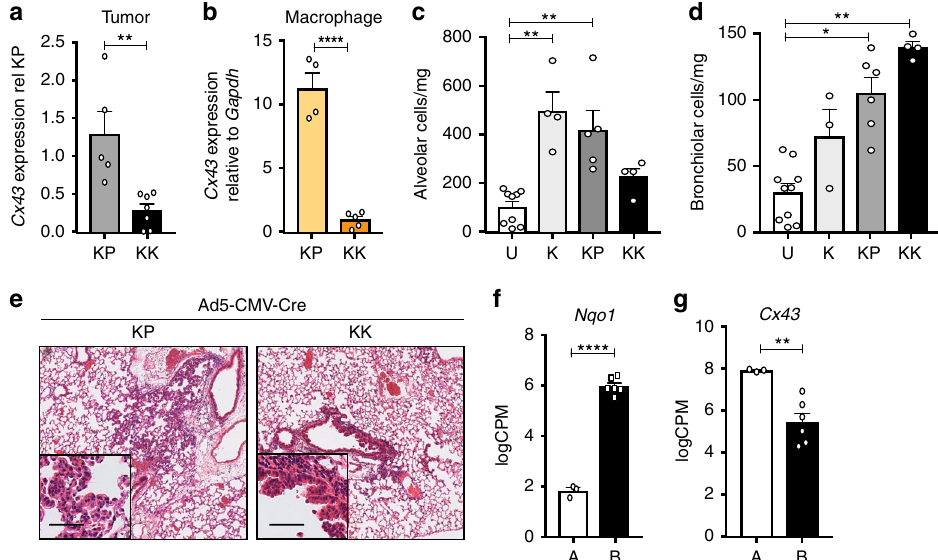
Fig. 4 Keap1 loss preferentially transforms bronchiolar cells. a Expression of Cx43 in KP ( n = 5) and KK ( n = 7) tumor pieces, relative to KP. Mann – Whitney test ** p = 0.0025. Mean ± SEM. b Expression of Connexin-43 ( Cx43 ) in alveolar macrophages isolated from KP ( n = 4) and KK ( n = 5) tumor-bearing lungs, relative to Gapdh control. Unpaired student t test **** p < 0.0001. Mean± SEM. c Quanti fi cation of alveolar (EpCAM + CD104 − ) compartment in uninfected (U; n = 9) and K ( n = 4), KP ( n = 4) and KK ( n = 5) 3 months post Ad5-CMV-Cre administration. Kruskal – Wallis test/Dunn ’ s multiple comparisons test, U v K ** p = 0.0034, U v KP ** p = 0.0095. Mean ± SEM. d Quanti fi cation of bronchiolar (EpCAM + CD104 + ) compartment in uninfected (U; n = 9) and K ( n = 3), KP ( n = 4) and KK ( n = 6) 3 months post Ad5-CMV-Cre administration. Kruskal – Wallis test/Dunn ’ s multiple comparisons test, U v KK ** p = 0.0014, U v KP * p = 0.0308. Mean ± SEM. e Representative H&E stained KP and KK lungs 3 weeks post Ad5-CMV-Cre infection. Scale, 200 μ m; inset, 50 μ m. f Expression of Nqo1 in alveolar (A) and bronchiolar (B) cells ( n = 3). ****FDR p < 0.0001. Mean± SEM. g Expression of Cx43 mRNA in alveolar (A) and bronchiolar (B) cells ( n = 3). **FDR p = 0.0055. Mean ±